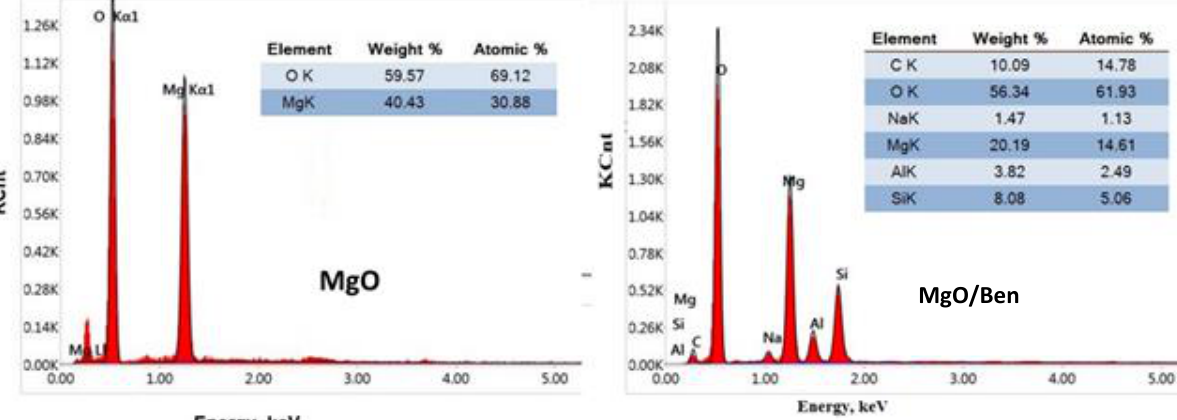
Figure 3. EDX graph of MgO NPs and MgO/Ben nanocomposite.